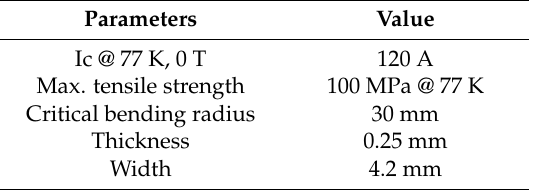
Table 1. Key parameters of the high temperature superconducting (HTS) wire.